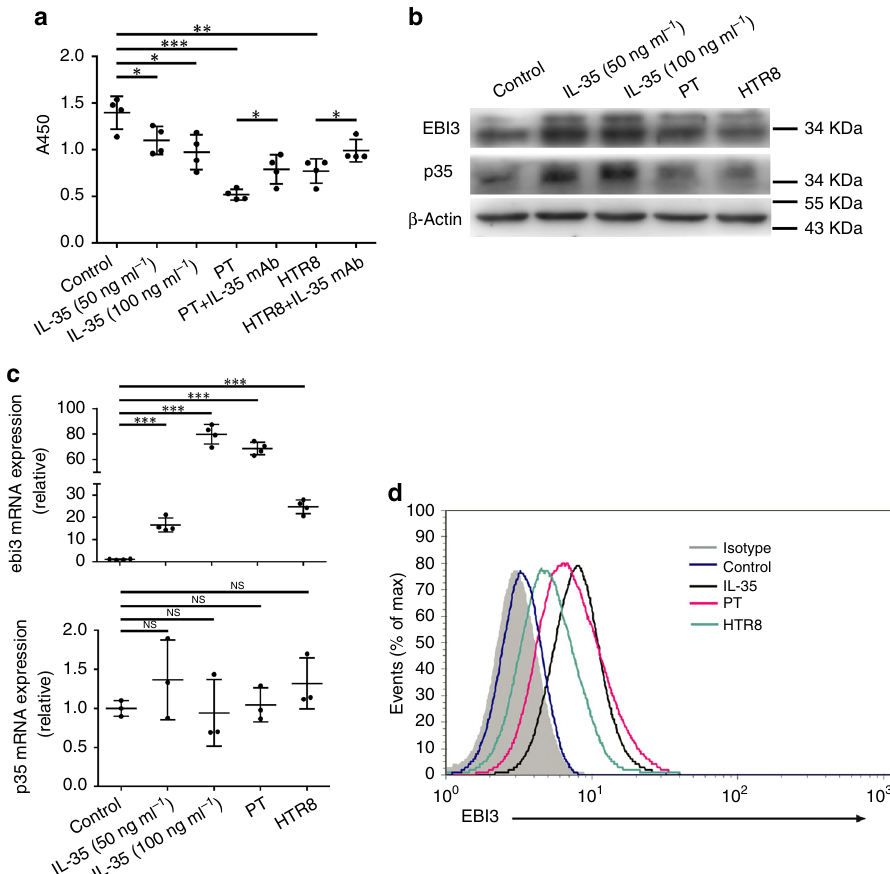
Fig. 2 Trophoblast cells inhibit the proliferation of T conv and mediate its conversion via secreting IL-35. T conv cells were cultured in medium (control) alone, or with human r-sc-IL-35 (IL-35) (50 ng ml − 1 or 100 ng ml − 1 ), or with trophoblast cells supernatant (with or without neutralizing anti-IL-35 mAb) in presence of anti-CD3/anti-CD28 beads and IL-2 for 5 days. a Then, the proliferation of T conv cells was evaluated by CCK8 assay ( n = 4). b The protein levels of EBI3 and p35 in treated T conv cells were determined by western blot ( n = 3). c The mRNA levels of ebi3 ( n = 4) and p35 ( n = 3) in T conv cells were detected by quantitative real-time RT-PCR. The results were normalized to endogenous control ( GAPDH ). d Flow cytometric analysis of EBI3 in treated T conv cells. Cells were harvested and stained with anti-EBI3 or isotype-matched control antibody (Isotype) after activated with Cell Activation Cocktail ( n = 3). Data were represented as mean ± SD. Signi fi cance was determined by Student ’ s t test analysis. * P < 0.05, ** P < 0.01, and *** P <